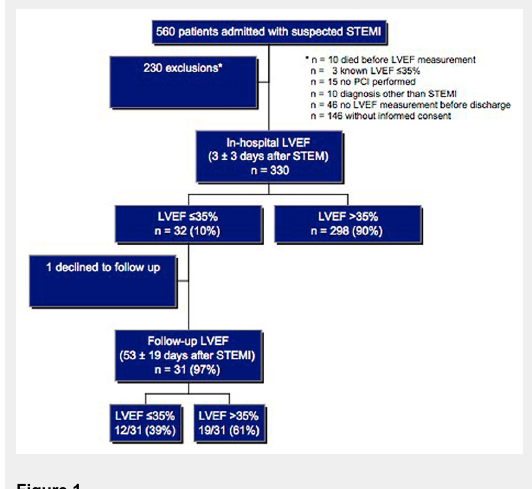
Study flow chart – patient recruitment and group outcome. LVEF = left ventricular ejection fraction; STEMI = ST-segment elevation myocardial